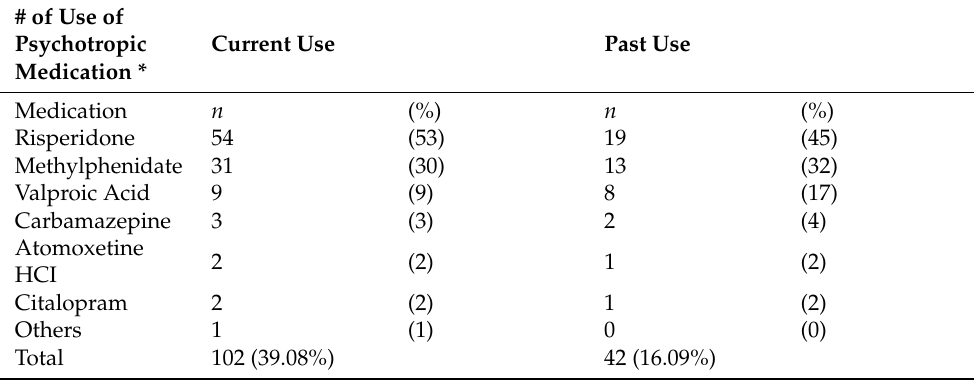
Table 2. Comparison between current and past use of medication among